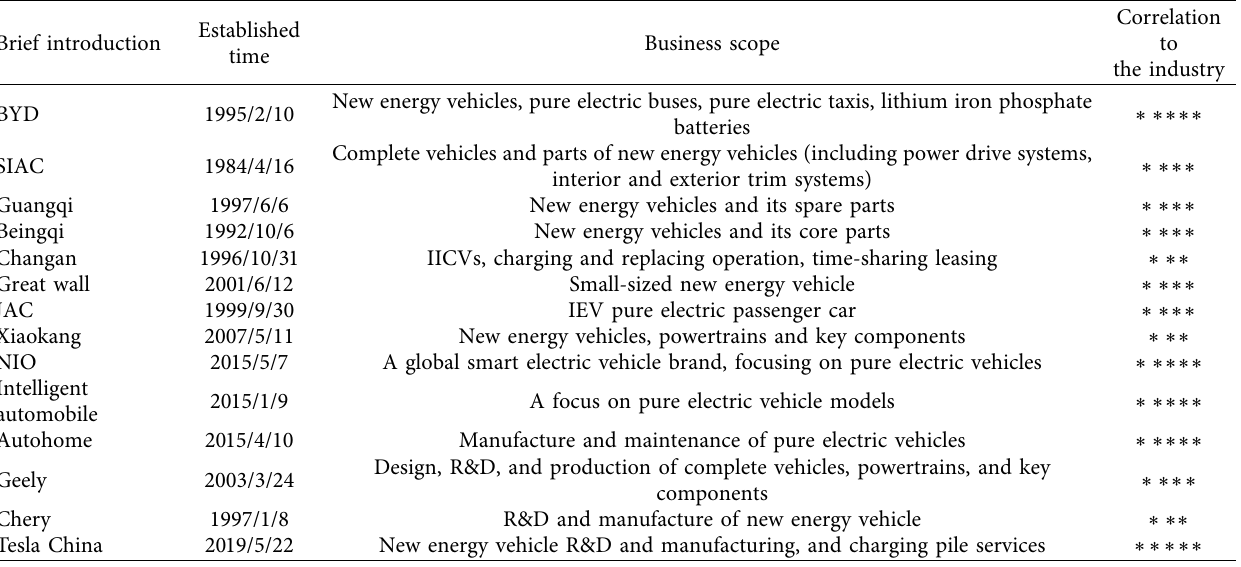
Table 1: Basic information of China’s new energy vehicle enterprises in 2021.